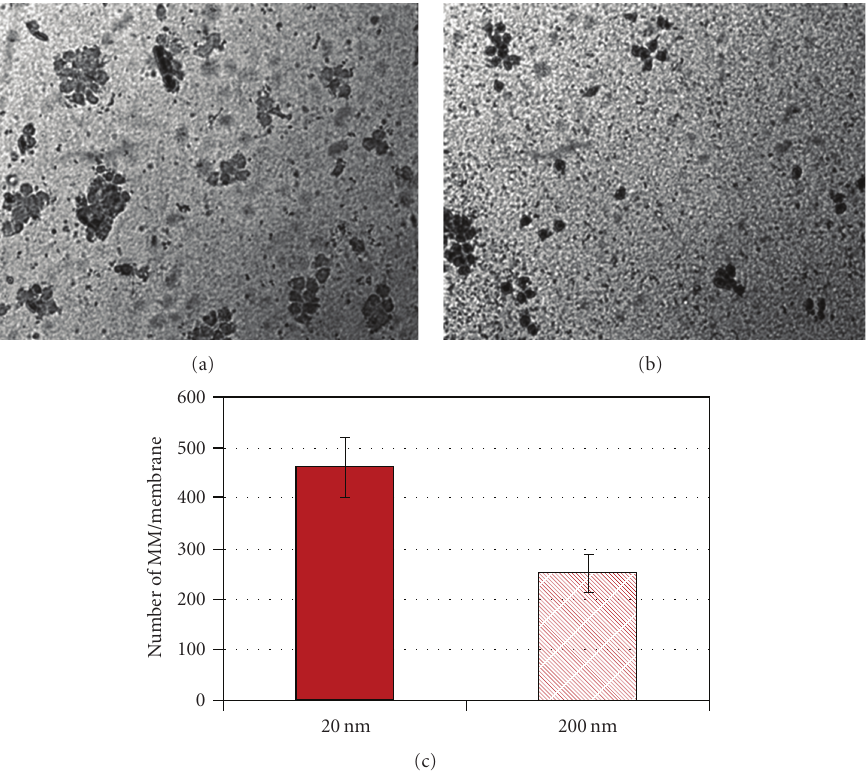
Figure 2: Representative light microscopy images of crystal violet-stained MM on (a) 20nm-pore alumina and (b) 200nm-pore alumina. (c) Number of MM on alumina membranes determined by means of light microscopy. Cells were counted in 9 representative 20x objective fields on each membrane. Data represents the mean ± SE from experiments using blood from 7 di ff erent donors. Cell adhesion on the 20nm-pore alumina membrane was significantly higher than on the 200nm-pore alumina ( P < . 05).